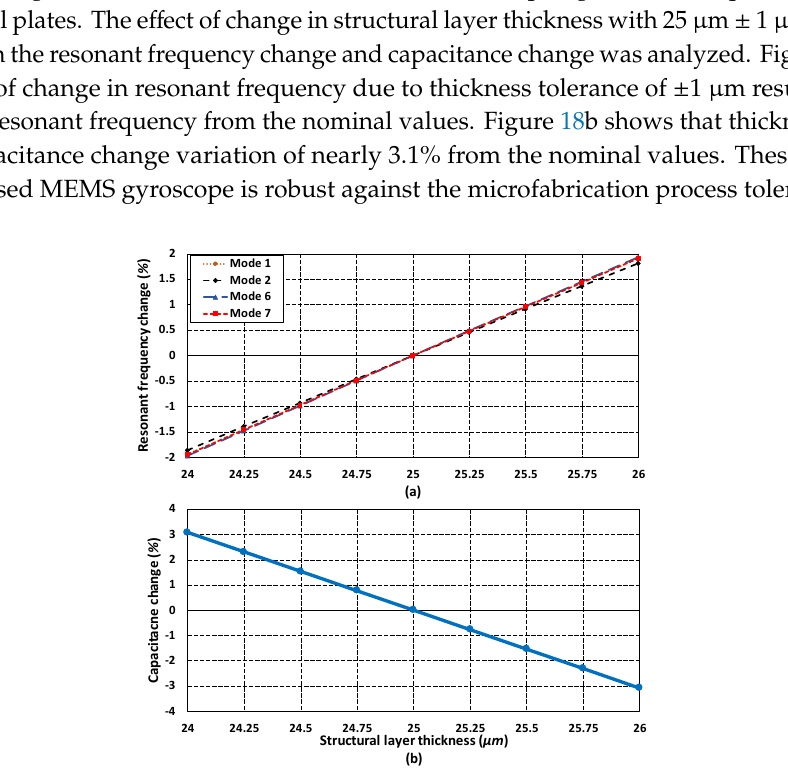
Figure 18. Effect of fabrication process tolerances on ( a ) resonant frequencies ( b ) capacitance change.